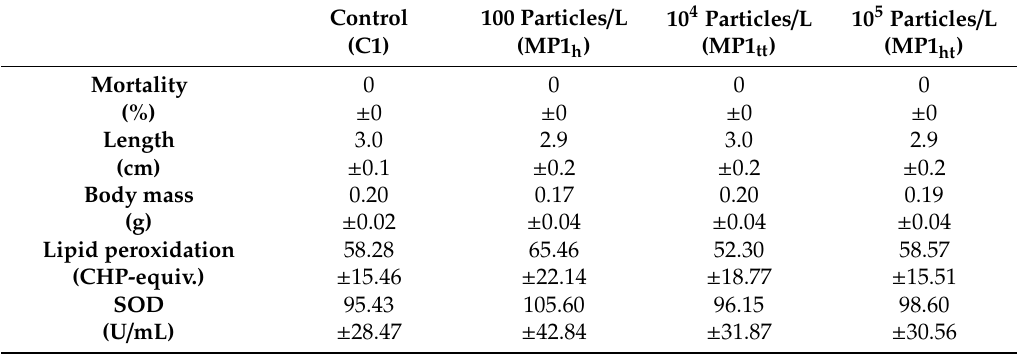
Table 2. Summary of data for the investigated endpoints in experiment 1b. All data are given as arithmetic means ± standard